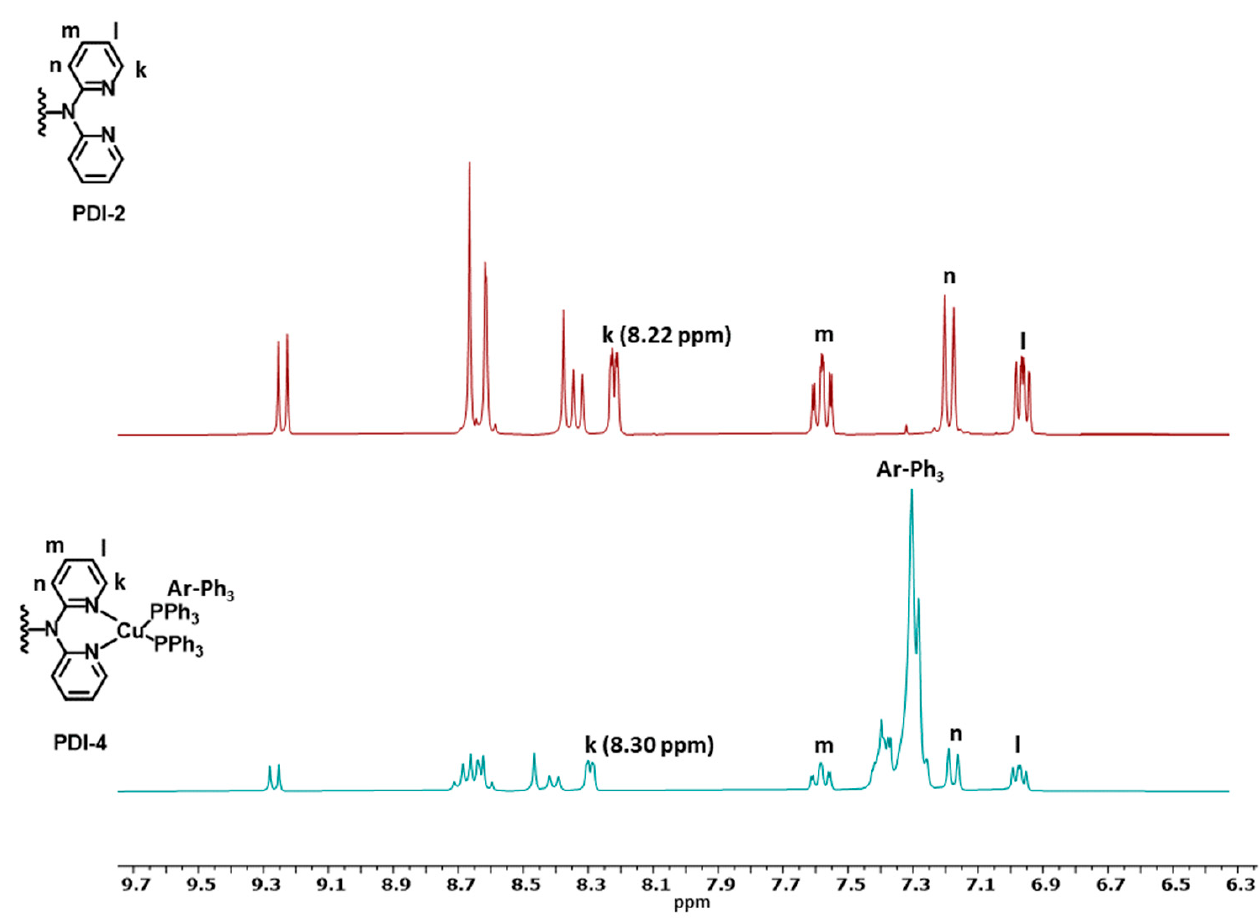
Figure 1. Part of 1 H NMR of PDI-2 (red) and PDI-4 (blue) in CD 2 Cl 2 at 25 °C. Letters over the NMR signals refer to the different hydrogen atoms of the ligands (see figures in the inset).